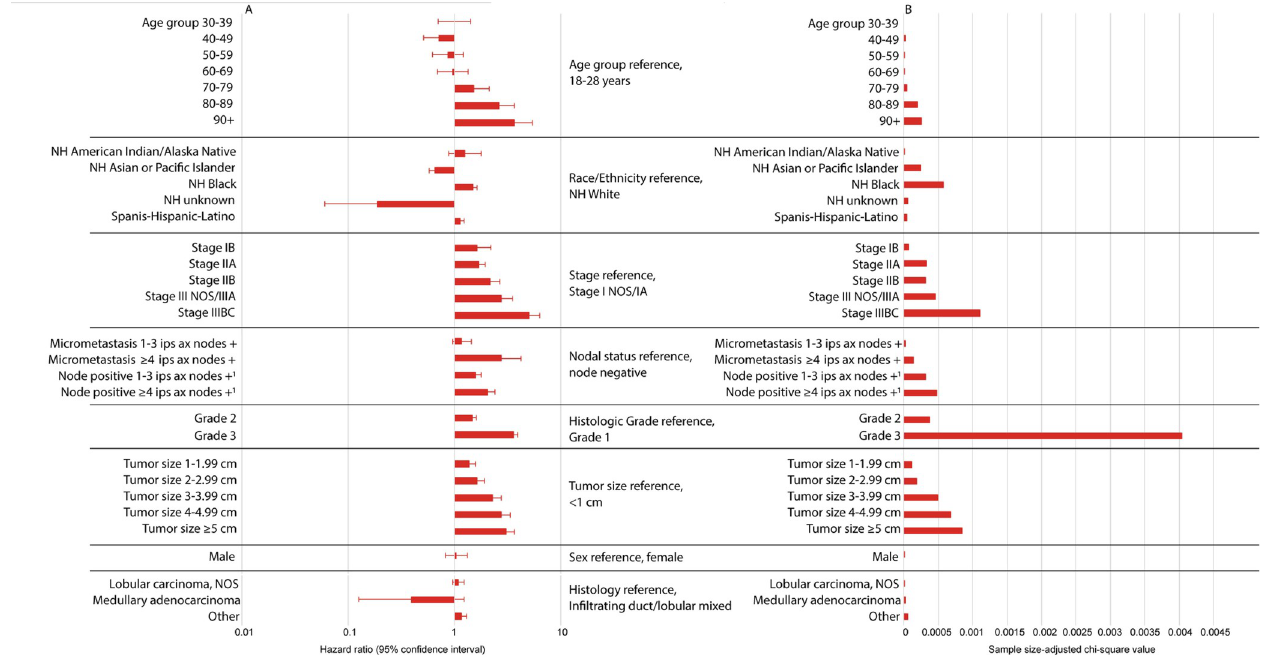
Fig 3. Breast cancer-specific mortality risk factors for patients with HR+, HER2- EBC. Hazard ratios and 95% confidence intervals (A), and sample size- adjusted Chi-square values (B) are presented for each risk factor and were derived from adjusted Cox proportional hazard models. 1 In these analyses, node positive was exclusive of the N1mi subgroups. Please refer to Materials and Methods section, Data Source subsection for detailed information regarding nodal status classification. Abbreviations: +, positive; AJCC, American Joint Committee on Cancer; Ax, axillary; cm, centimeter; HER, human epidermal growth factor receptor; HR, hormone receptor; Ips, ipsilateral; NH, non-Hispanic; NOS, not otherwise specified.